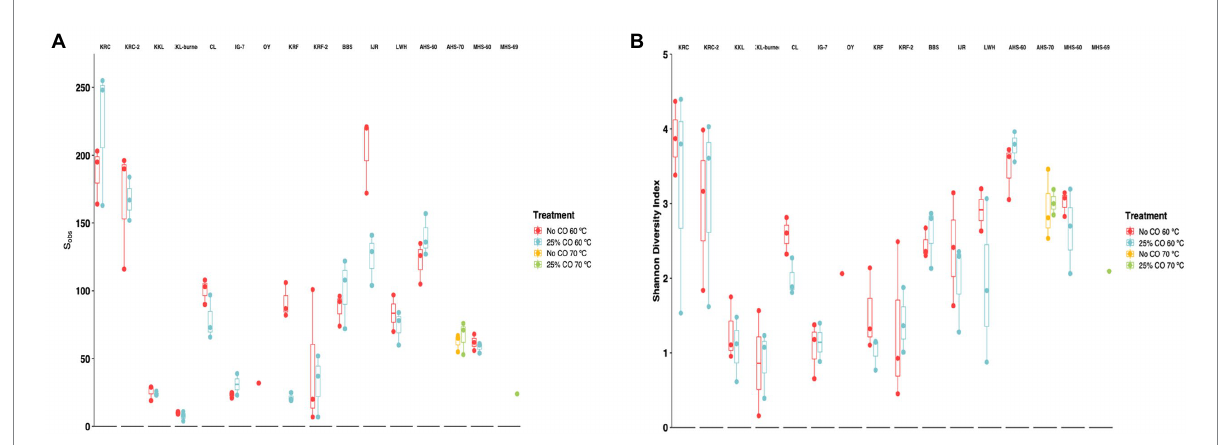
FIGURE 3 Alpha diversity for metrics for samples incubated under thermophilic conditions with and without 25% CO. Observed richness, Sobs (A) and Shannon diversity index (B) Bars in box and whisker plots represent median values. Site abbreviations are described in the legend for Figure